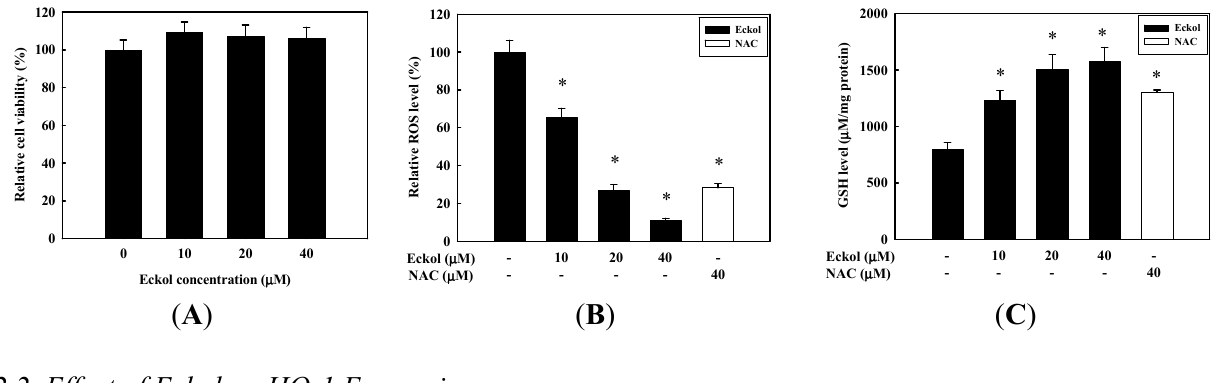
Figure 2. Effect of eckol on the inhibition of ROS production in HepG2 cells. ( A ) Cells were treated with eckol for 24 h at the indicated concentrations. The cell viability was determined by MTS assay kit; ( B ) The cells pretreated with indicated concentration of eckol or NAC (40 μ M) for 2 h were stimulated with 0.5 mM H 2 O 2 for 30 min. ROS levels were measured by DCF-DA with fluorescent analysis; ( C ) The cells were treated with indicated concentration of eckol or NAC (40 µM) for 2 h and cellular GSH was measured with assay kit. Values are the mean ± SD of three independent experiment. * p < 0.05 indicates significant differences compared to the control group.